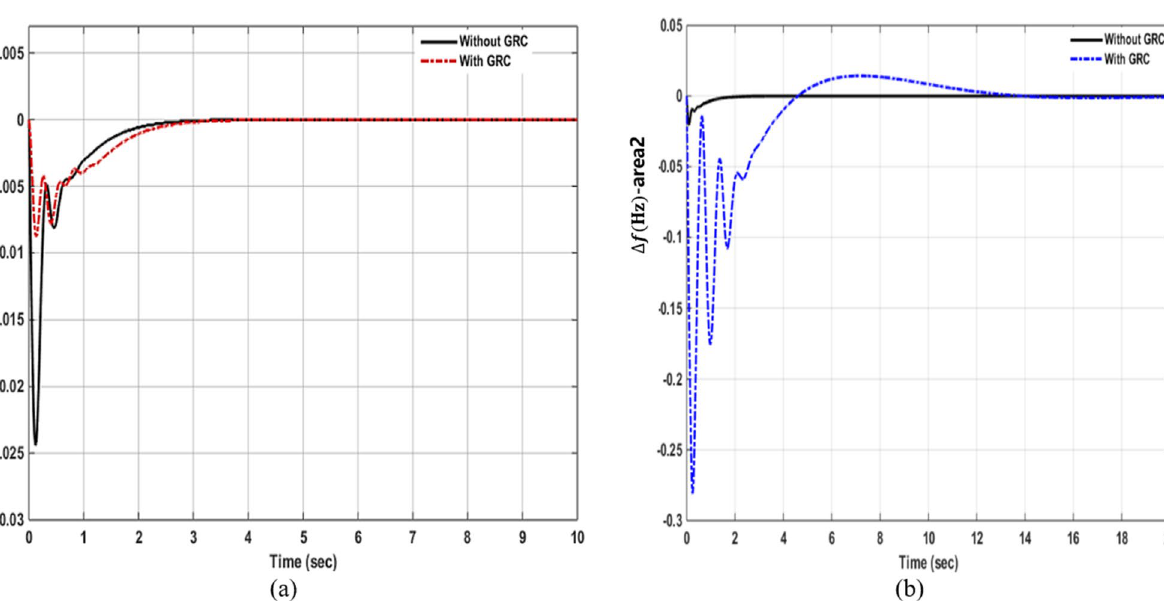
Figure 18. Frequency deviation response to 1% SLP in multi-source power system with and without GRC for thermal plant ( a ) Area 1, ( b ) Area